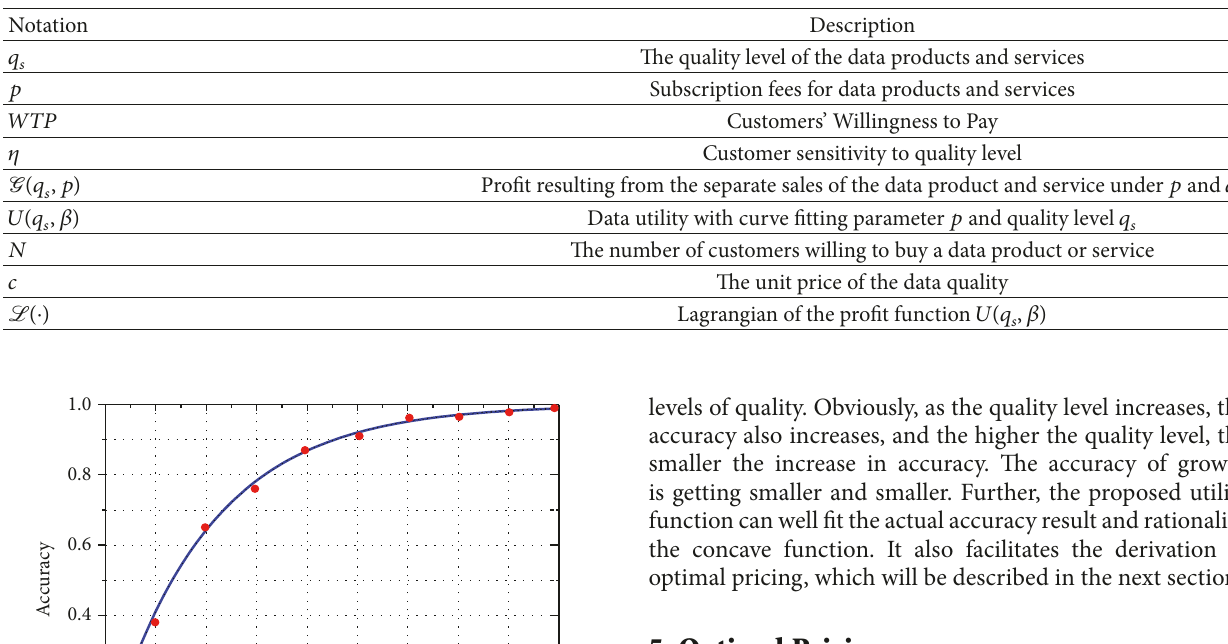
Table 2: Frequently used notations.